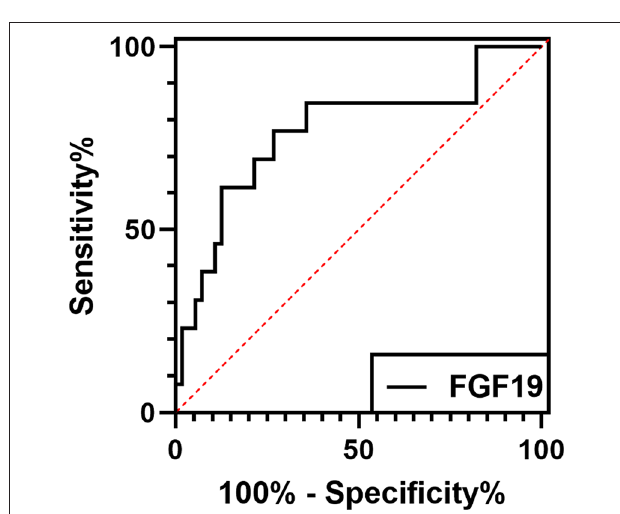
FIGURE 3 | The receiver operating characteristic (ROC) curve showed that FGF19 had a high predictive value of subAS in men. The serum FGF19 levels in the baseline group had an area under the curve (AUC) of 0.769 in